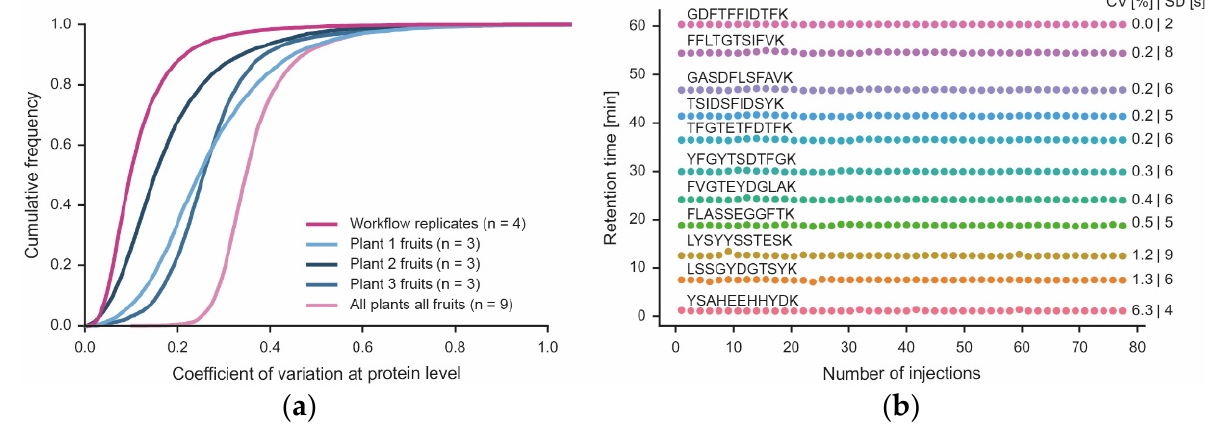
Figure 4. Quantitative precision of the workflow and biological proteome variation. ( a ) Cumulative density plot of the quantitative precision (expressed as coefficient of variation, CV) of four technical workflow replicates using material from the same tomato fruit, three different fruits of each of three plants (Plant 1–3) and all tomato fruits from all plants combined. ( b ) Retention time stability of 12 synthetic peptides spiked into each of the 78 samples (injections) analyzed in this study. Each sample was analyzed by a 60 min LC-MS/MS run. The retention time variation of each peptide is expressed as CV and standard deviation (SD).